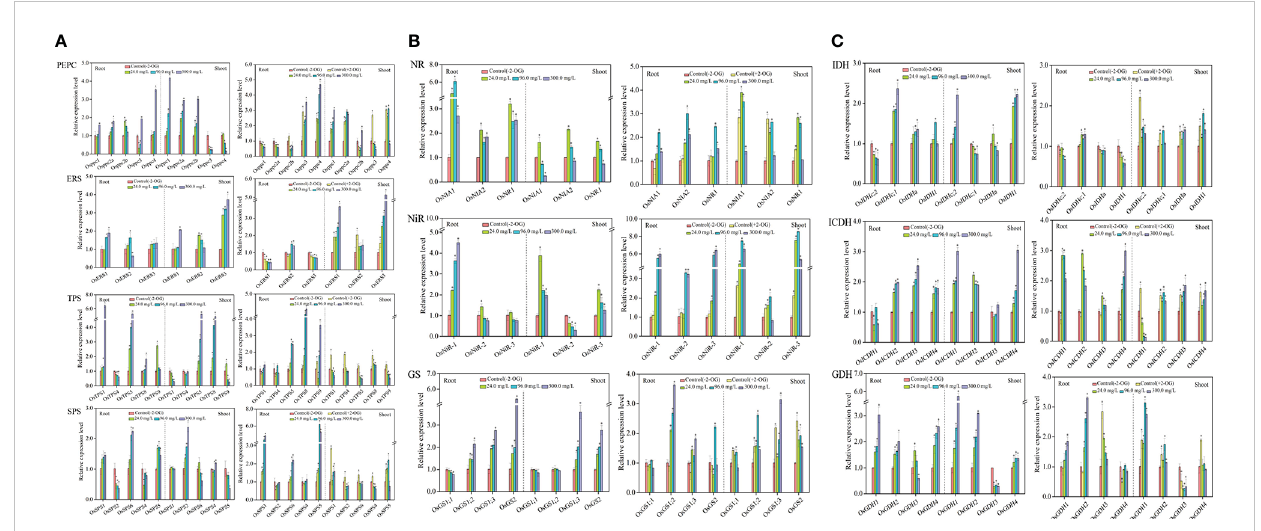
FIGURE 2 Response of CNM-related genes in rice roots and shoots under SCN − stress in the presence or absence of 2-OG. (A) Response of C metabolism- related genes. (B) Response of N metabolism-related genes. (C) 2-OG synthesis-related genes. The asterisk symbol refers to the signi fi cant difference between SCN − -treated (24.0, 96.0, and 300.0 mg SCN/L) and SCN − +2-OG-treated (0, 24.0, 96.0, and 300.0 mg SCN/L) seedlings and control 1 ( p < 0.05). CNM, carbon and nitrogen metabolism; 2-OG,